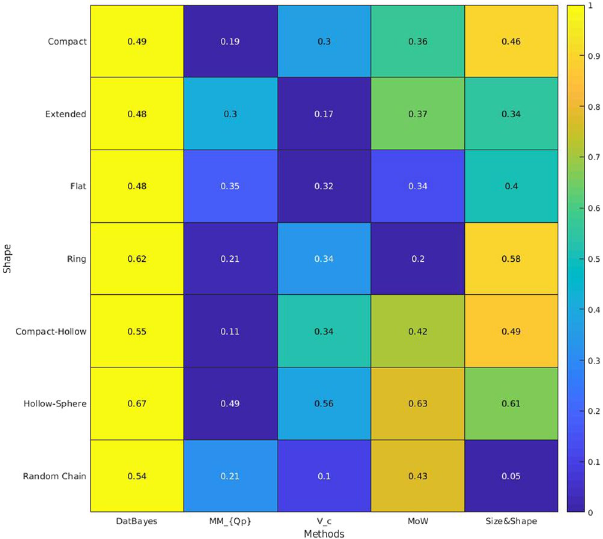
Figure 7. Performance of the methods for different protein shapes. Heatmap assessing the performance of the method against the protein shape, as determined by the protein classifier algorithm DATCLASS 17 . The color represents the fraction of the cases at which each method yielded the most accurate MM as determined by the smallest relative error. The figure comprises the results from all noise levels, a total of 6 noise levels each containing 16,563 unique profiles, amounting to 99,378 profiles.